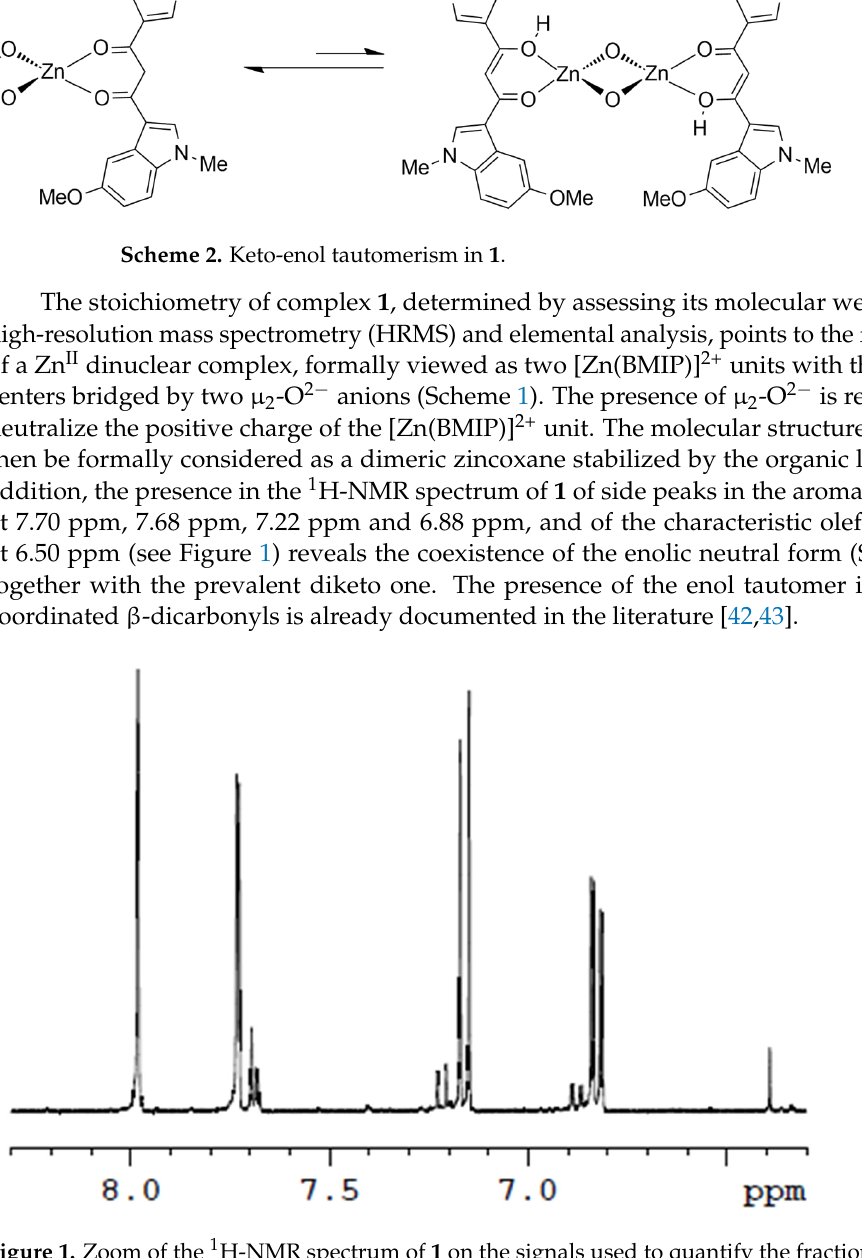
Figure 1. Zoom of the 1 H-NMR spectrum of 1 on the signals used to quantify the fraction of diketo tautomer.